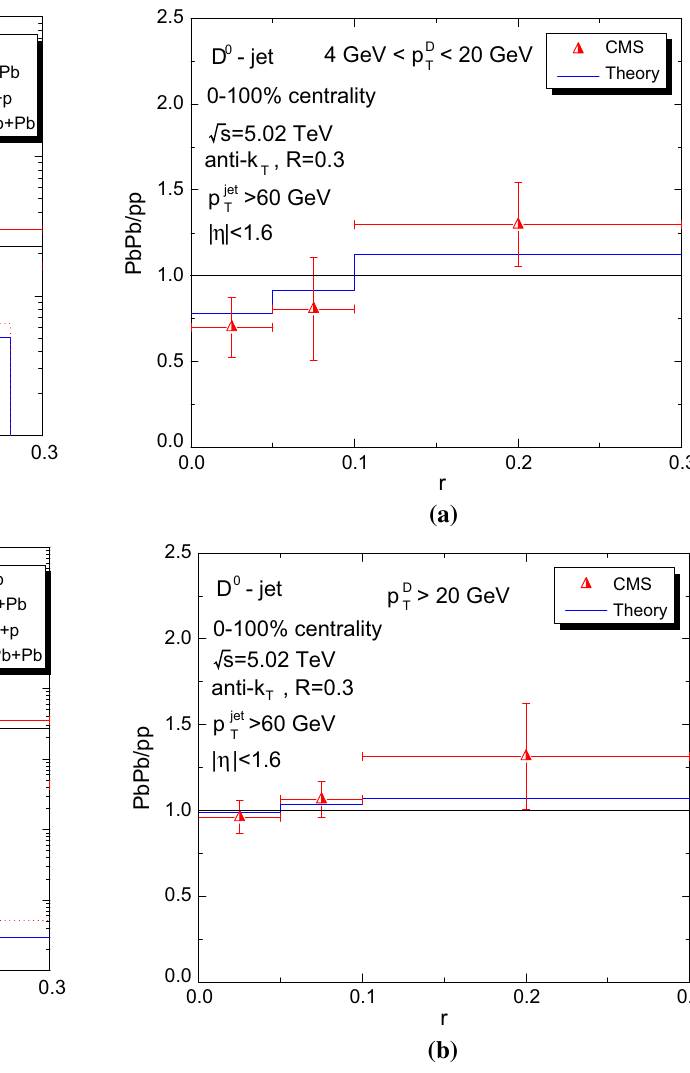
Fig. 3 Radial distributions of D 0 meson in jets at a 4 GeV < p D > 20 GeV both for p + p and Pb + Pb are compared 20 GeV and b p D T to the CMS data [57]